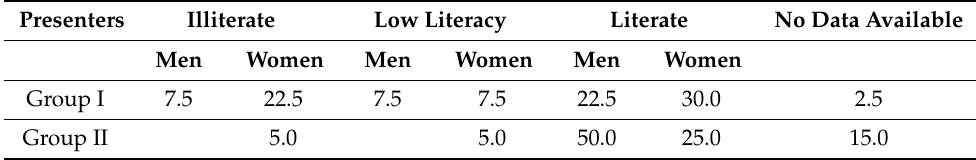
Table 1. Age of the presenters (data are presented in percentage).